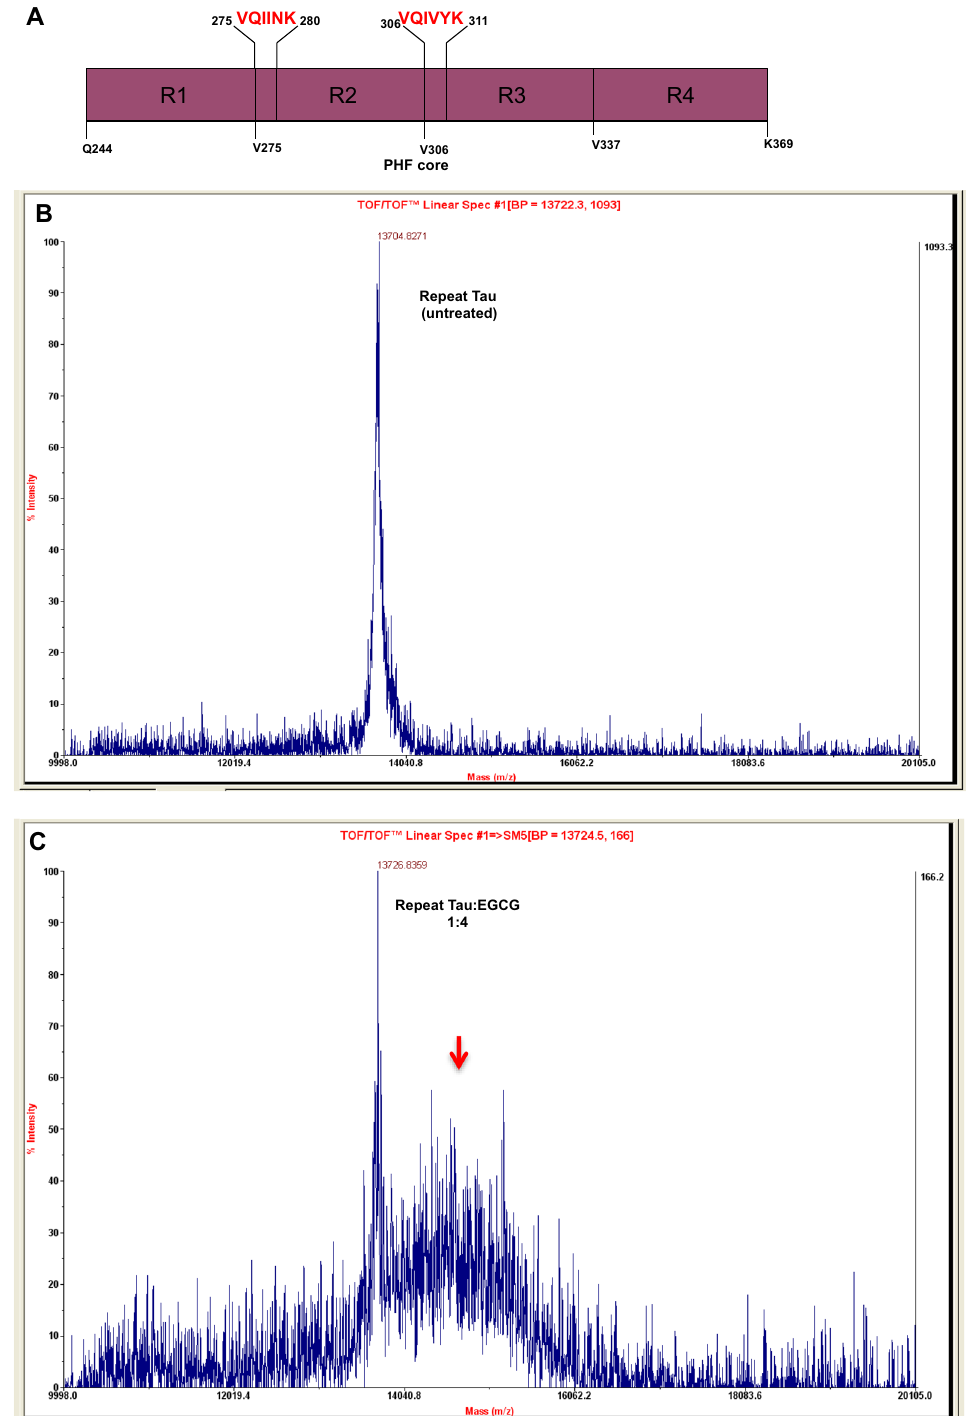
Figure 6. Modification of repeat Tau by EGCG. ( A ) Repeat domain of Tau showing two hexapeptide motifs. ( B ) The MALDI-TOF spectra of untreated repeat Tau showing a single peak at desired molecular weight of 13.7 KDa. ( C ) The EGCG treated repeat Tau shows an adjacent peak (red arrow) in addition to the soluble Tau peak suggesting the modification of Tau with EGCG as increase in molecular